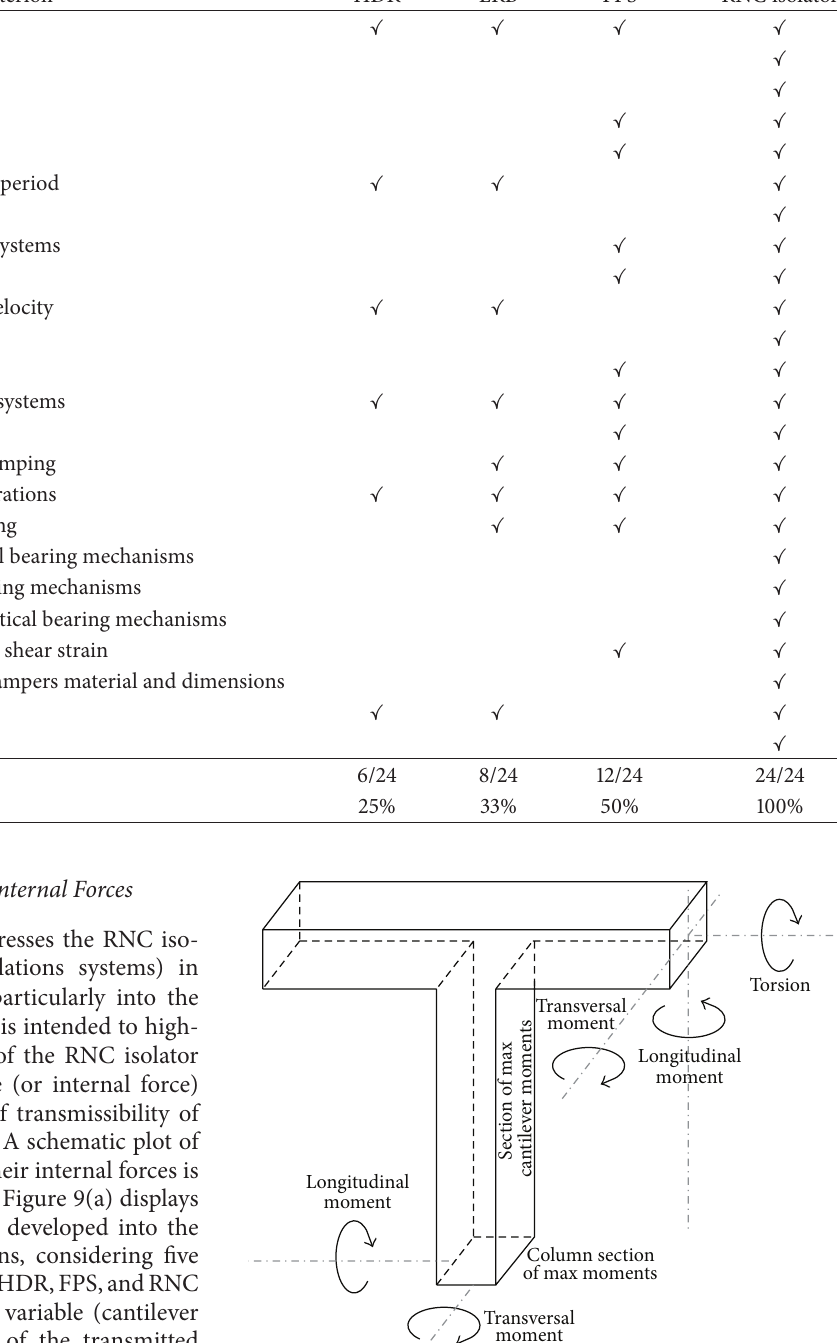
Table 2: A comparison between the used four isolation systems. Design feature, functionality, or behavior criterion